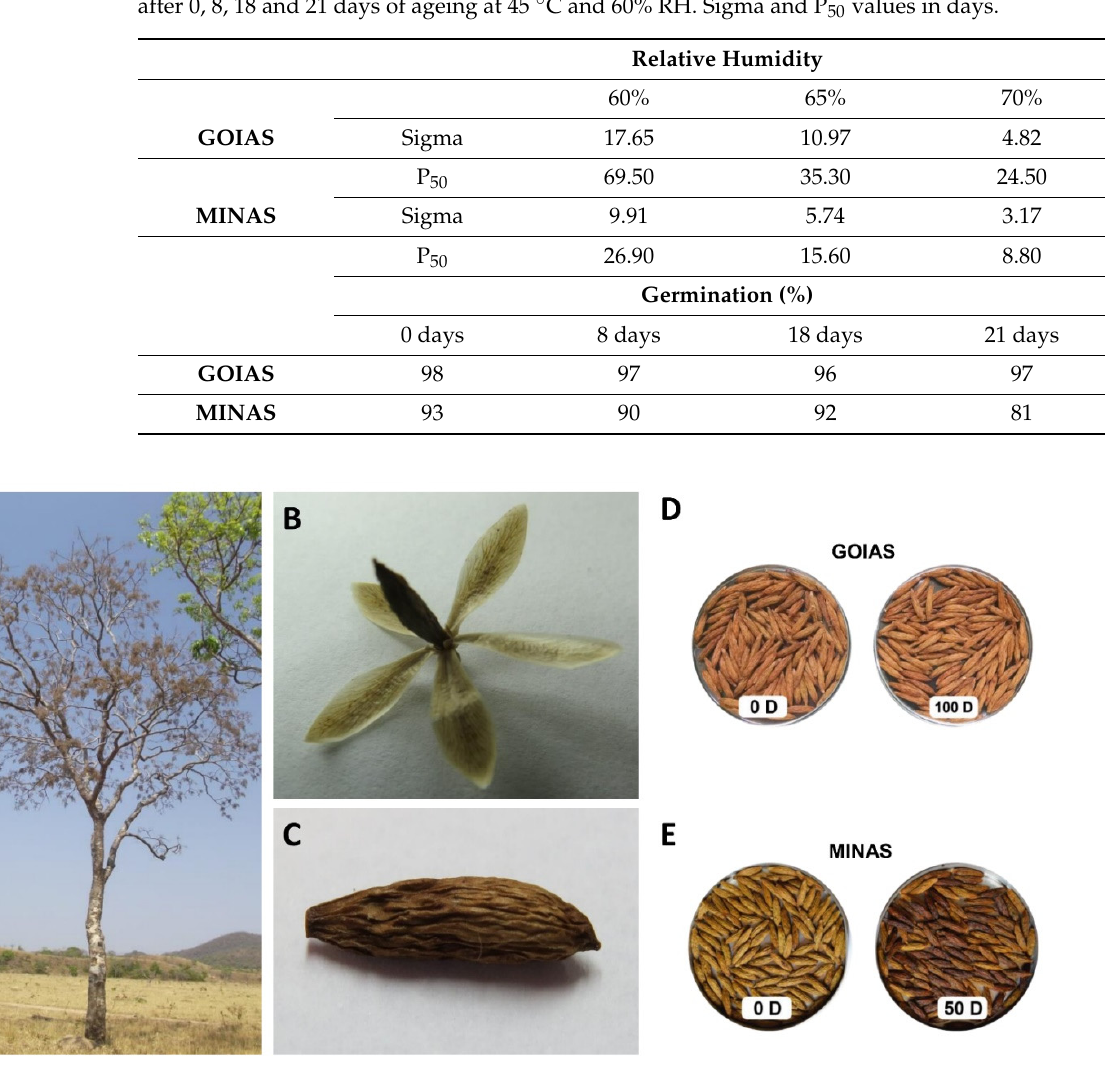
Figure 1. Morphological details of species, seeds and fruits of A. fraxinifolium ( A ) A. fraxinifolium tree. Tree without leaves and only fruits present. The tree has a medium arboreal size, with a height of 8 to 12 m, a cylindrical and straight trunk, 60 to 80 cm in diameter at breast height (DBH) and with whitish bark; ( B , C ) Fruit of A. fraxinifolium adhered to the calyx. The fruit is a pseudo-samara, with a uniseriate exocarp, suberified and attached to the mesocarp; ( D ) Seeds from accession GOIAS, submitted to the accelerated aging test at 60% RH with zero days of aging and 100 days of accelerated aging; ( E ) Seeds from accession MINAS, submitted to the accelerated aging test at 60% RH with zero days of aging and 50 days of accelerated